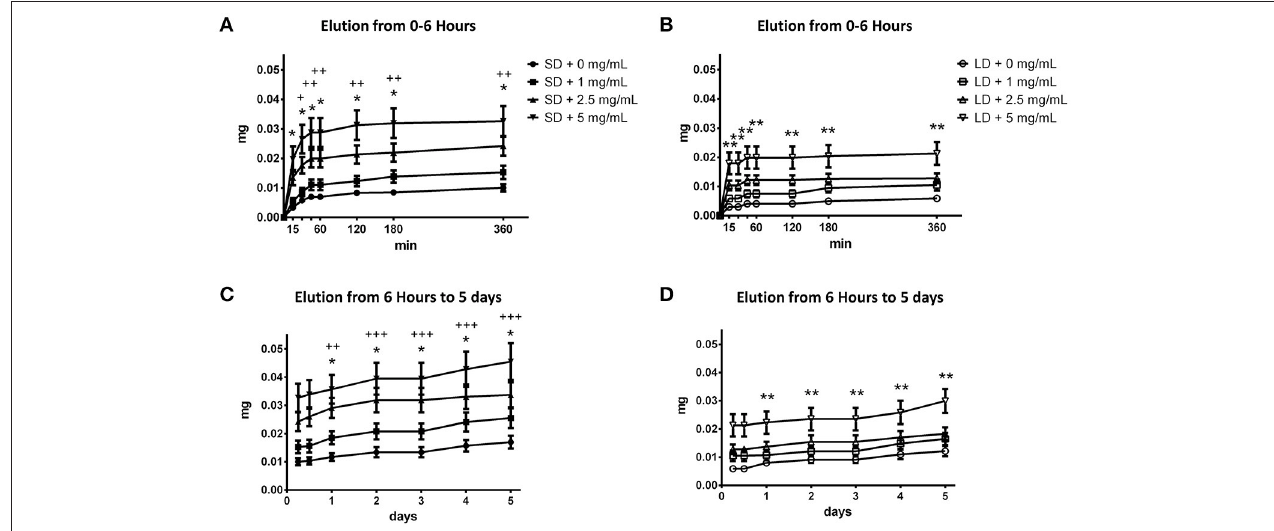
FIGURE 4 | SD and LD templates elute Cl-Am over 5 days. From 0min to 6h, the (A) SD templates eluted significantly more drug than the (B) LD templates. This trend was observed from 6h to 5 days for the (C) SD and (D) LD templates. *Significant difference between 2.5 mg/mL Cl-Am and 5 mg/mL Cl-Am from 0 mg/mL Cl-Am templates ( p < 0.05). **Significant difference between 5 mg/mL Cl-Am from 0 mg/mL Cl-Am templates ( p < 0.05). + Significant difference between SD and LD templates with 5 mg/mL Cl-Am ( p < 0.05). ++ Significant difference between SD and LD templates with 2.5 mg/mL and 5 mg/mL Cl-Am ( p < 0.05). +++ Significant difference between all SD and LD templates ( p < 0.05) (mean ± std. dev., n =